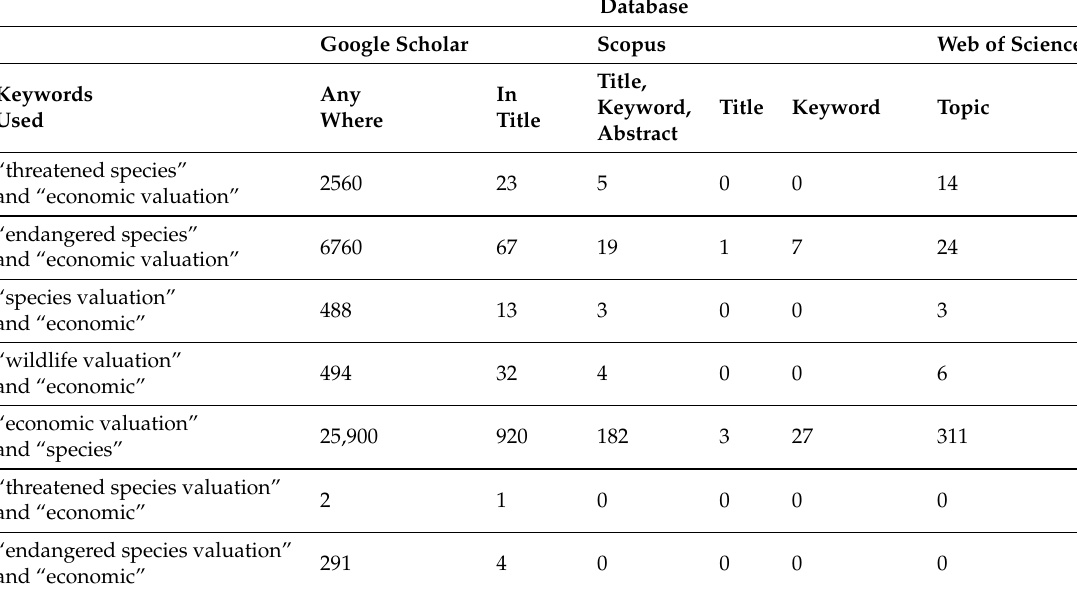
Table 1. Number of unique hits by keywords and database (as of 1 February